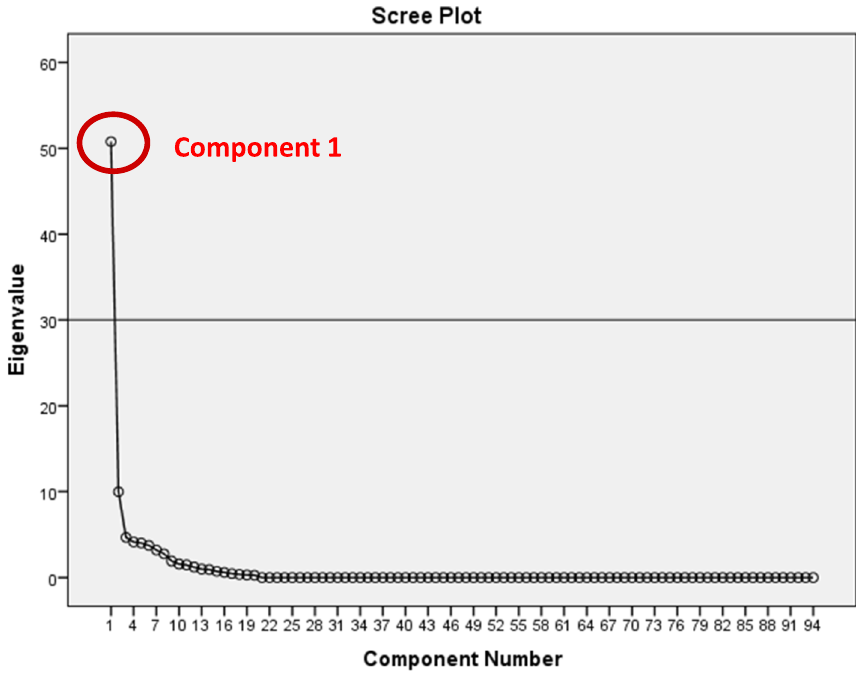
Fig. 9 Scree plot for the second runs (national variables)